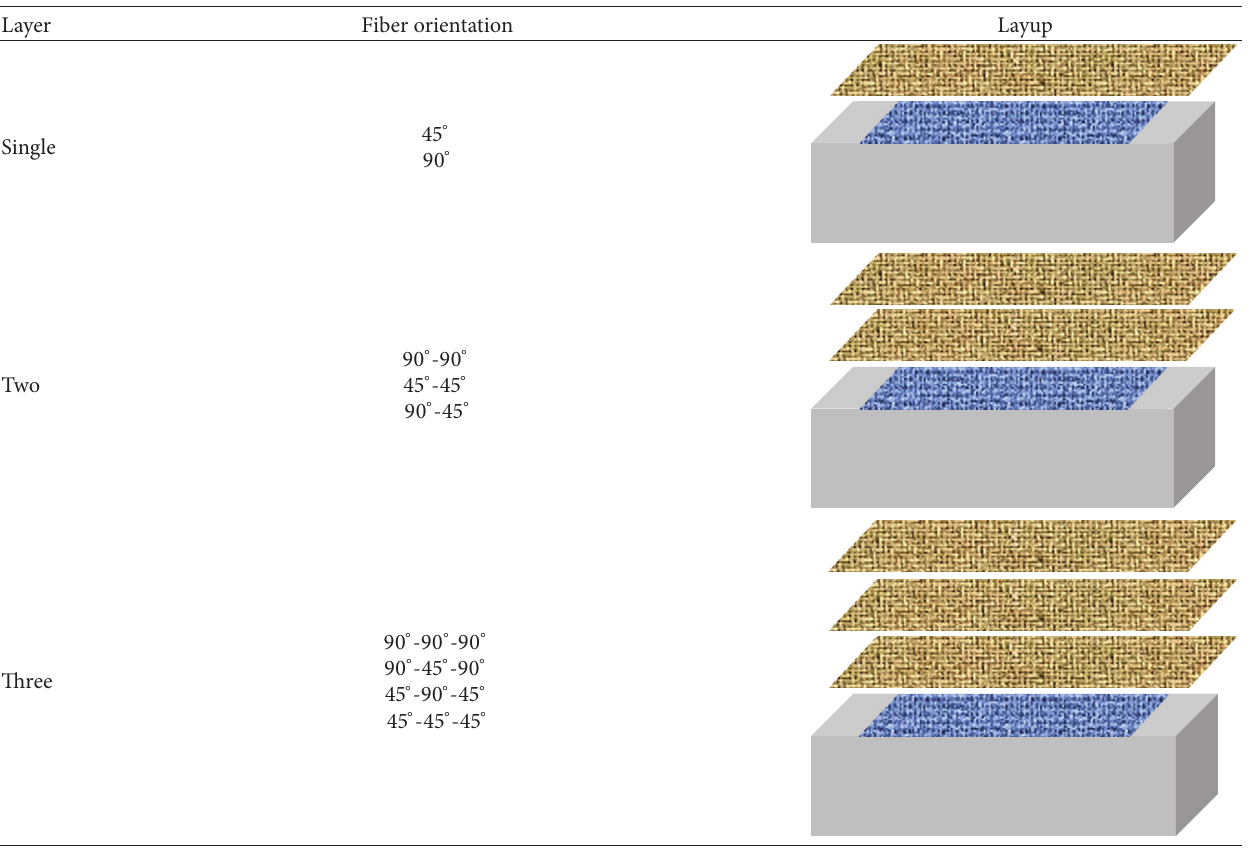
Figure 7: Load testing and failure under load. Table 4: Variable